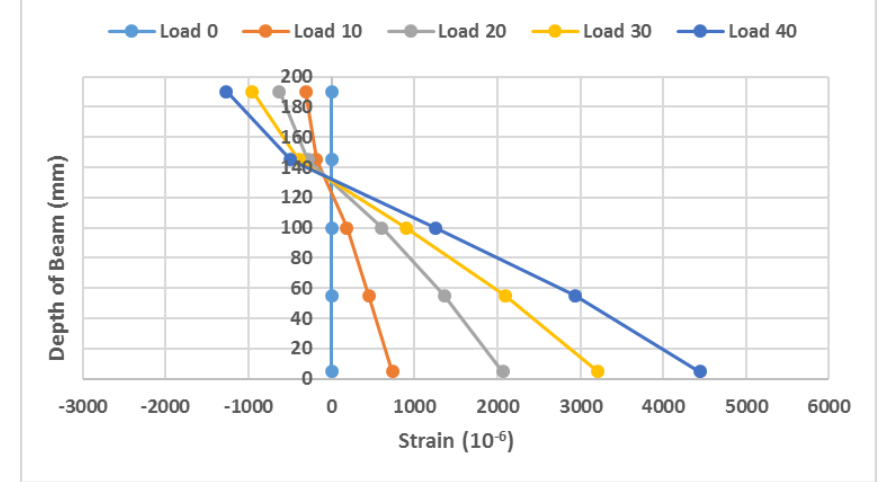
Figure 11. Depth of neutral axis for RC.